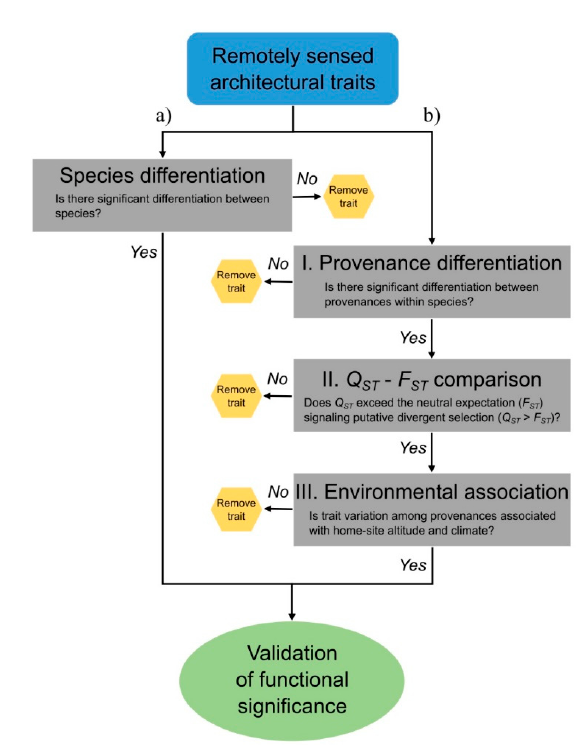
Figure 3. Conceptual diagram of the two-phased analytical framework ( a , b ) used to filter the